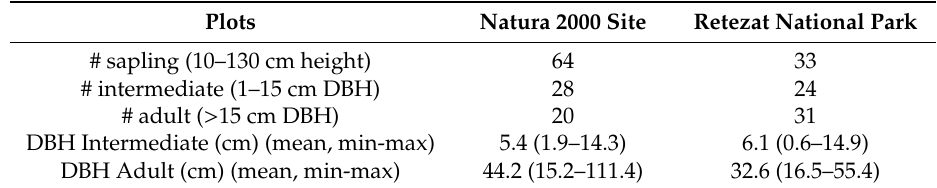
Table 1. Recorded individuals and diameter at breast height for three size classes of Pinus cembra L. in the Carpathian Mountains. Diameter at breast height (DBH).